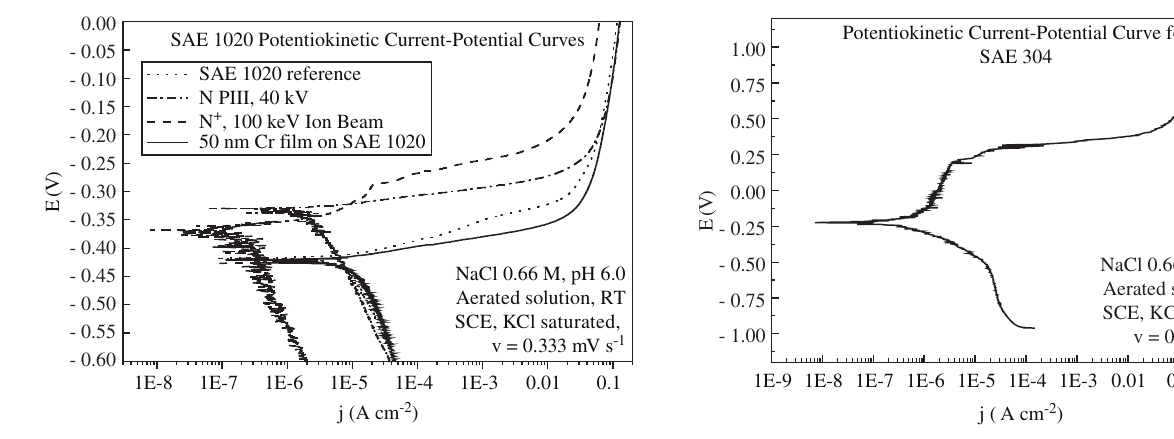
Figure 5. Corrosion profile of SAE 1020 steel after several treatment. Figure 6. Corrosion profile of SAE 304 stainless